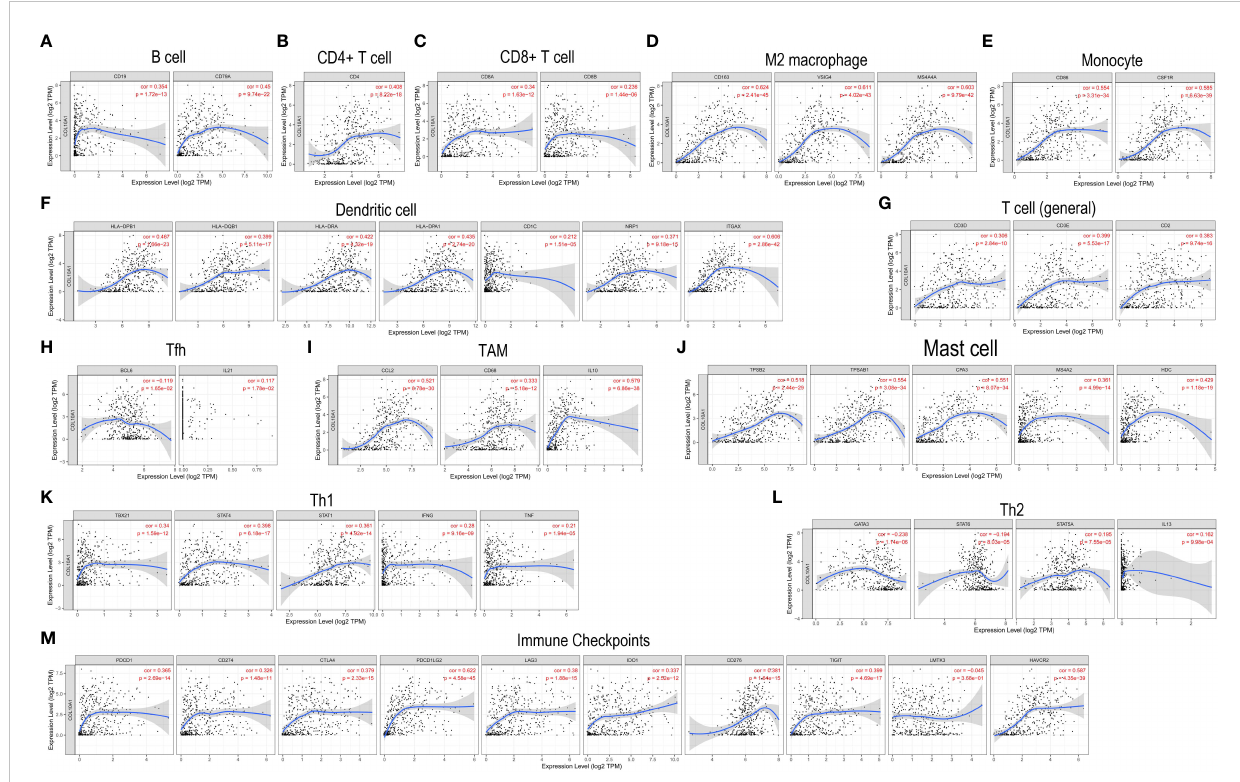
FIGURE 7 COL10A1 expression is related to immune in fi ltration degrees in BLCA. Spearman correlations between COL10A1 expression and twelve in fi ltrating immunocyte abundances: B cell (A) , CD4+ T cell (B) , CD8+ T cell (C) , M2 macrophage (D) , monocyte (E) , dendritic cells (F) , general T cells (G) , Tfh cell (H) , TAM (I) , mast cell (J) , Th1 cell (K) , Th2 cell (L) , and immune checkpoints genes (M)